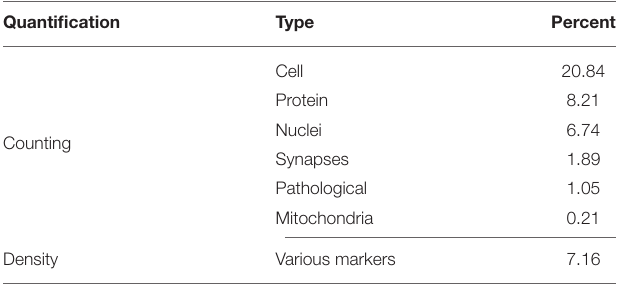
TABLE 5 | Quantifications performed on cerebral organoid images, given in percentage of the reviewed articles.